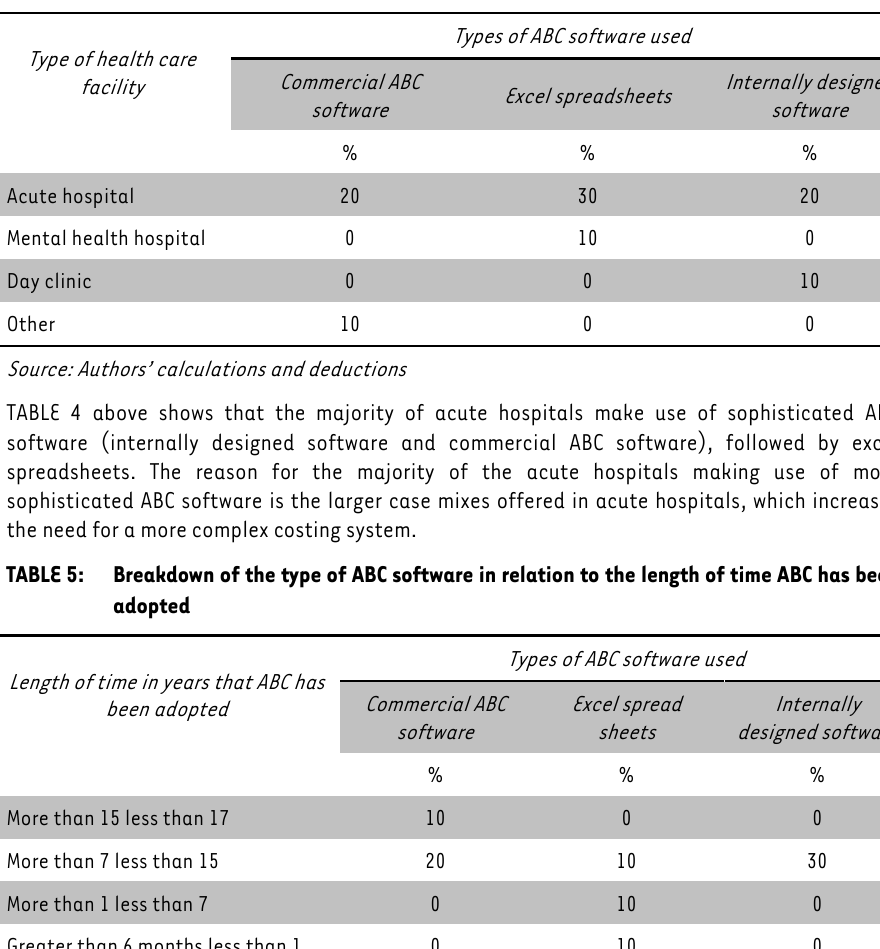
TABLE 4: Breakdown of the type of ABC software in relation to the type of health care facility Type of health care facility